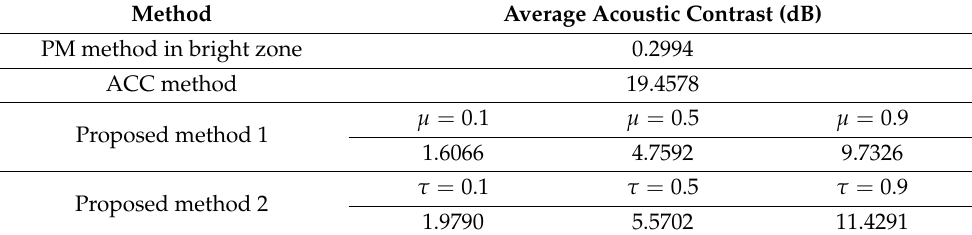
Table 9. Average acoustic contrast of different methods relative to frequency for two-dimensional experiment with sparse sampling points.